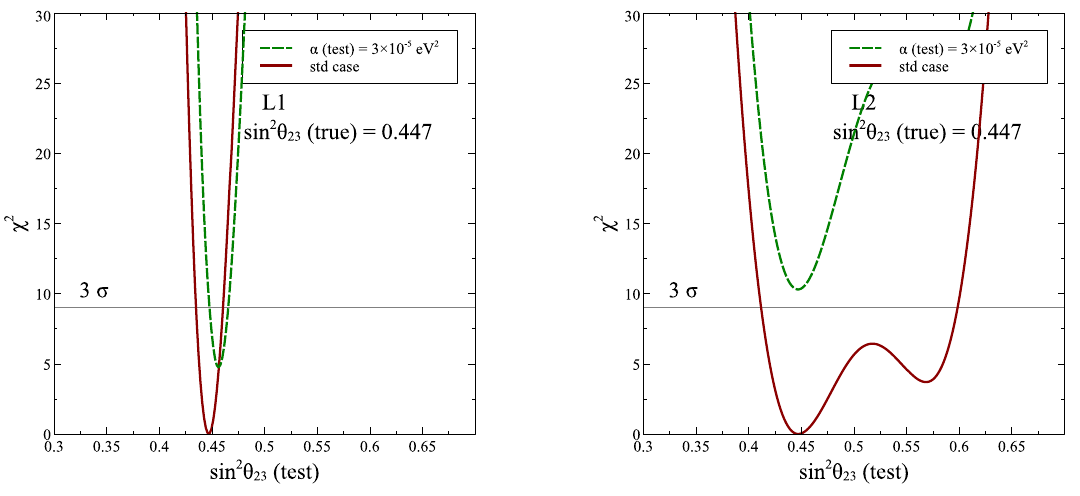
Figure 5 . The χ 2 as a function of θ 23 assuming the true sin 2 θ 23 = 0 . 447 . The left (right) panels are for baselines 295 (1100) km respectively. The dark red solid curves are for the standard cases and the green dashed curves are for the case when α = 0 in the simulated data but assumed to be 3 × 10 − 5 eV 2 in the